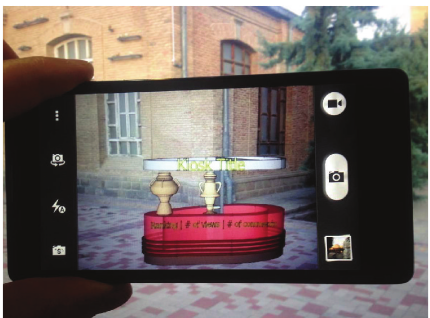
Figure 4: The 3D model of the kiosk is augmented on the image captured by the built-in camera of the